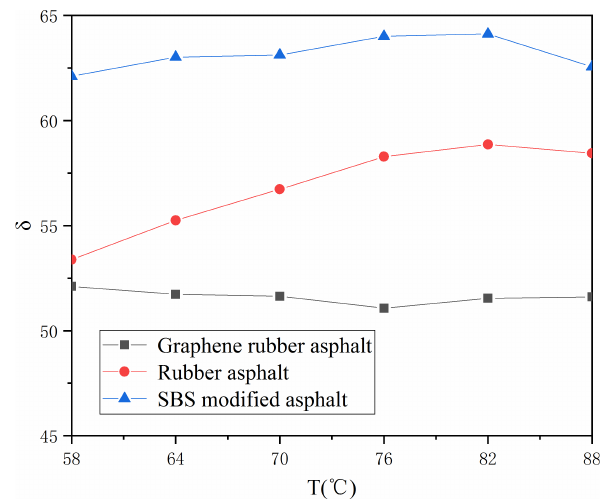
Figure 5: Relationship between δ and T Table 4: The MSCR results of